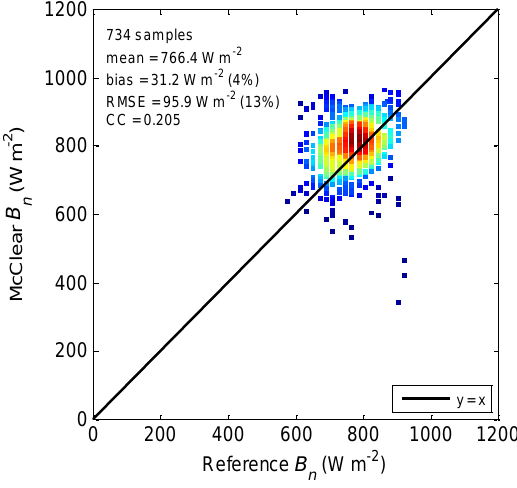
Figure 6. Scatter density plot between measurements of DNI and McClear estimates under cloud-free conditions at